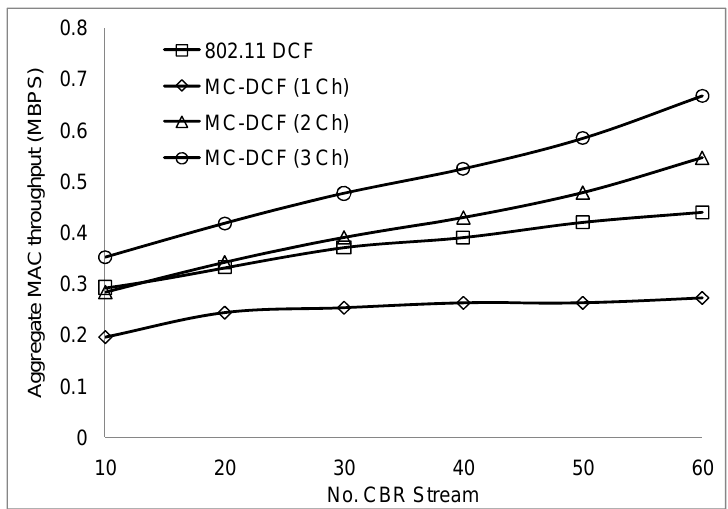
Figure 11. Throughput impact on CBR